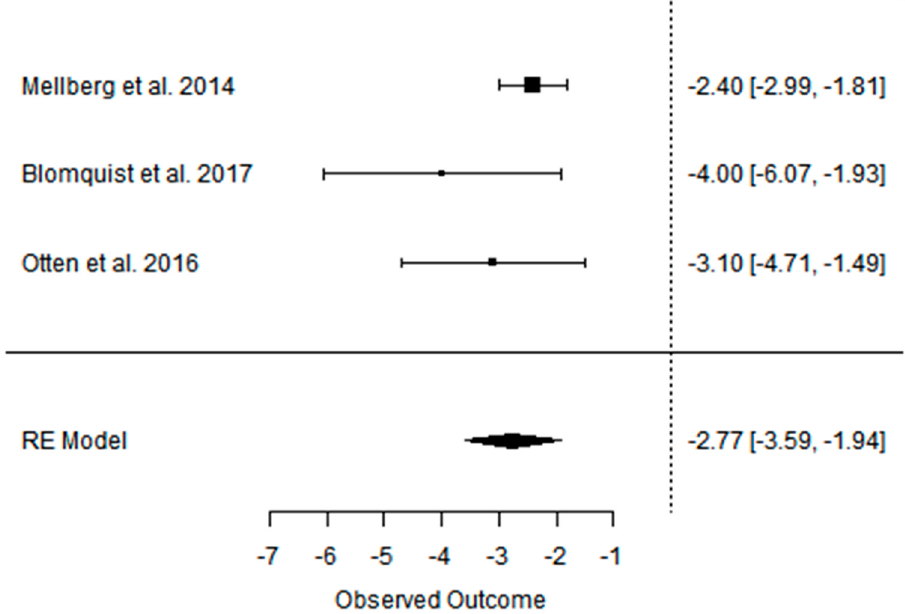
Figure A12. Forest plot of the effect of a PD on BMI in the long term (weighted mean difference).